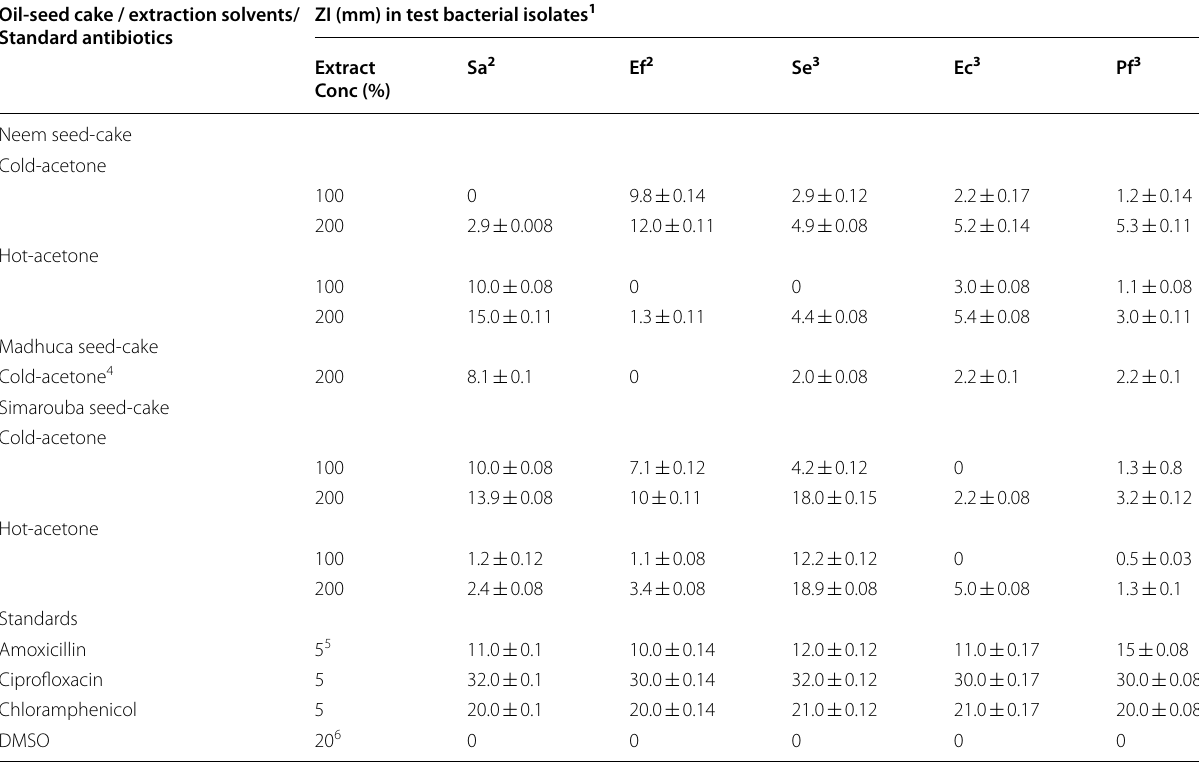
Table 1 Antibacterial activity of cold and hot acetone extracts of neem, madhuca, and simarouba oil-seed